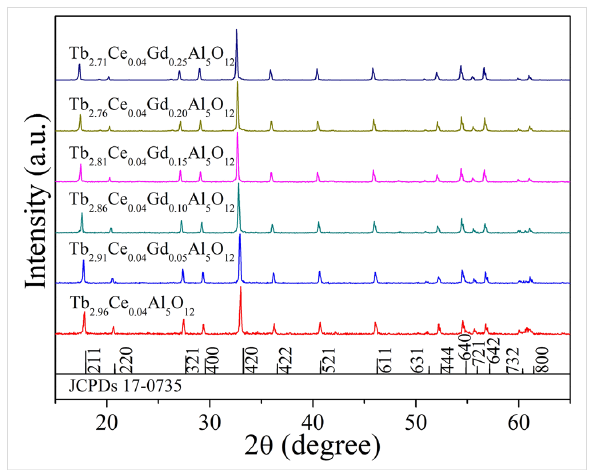
Figure 1: XRD patterns of Tb 2.96 − x Ce 0.04 Gd x Al 5 O 12